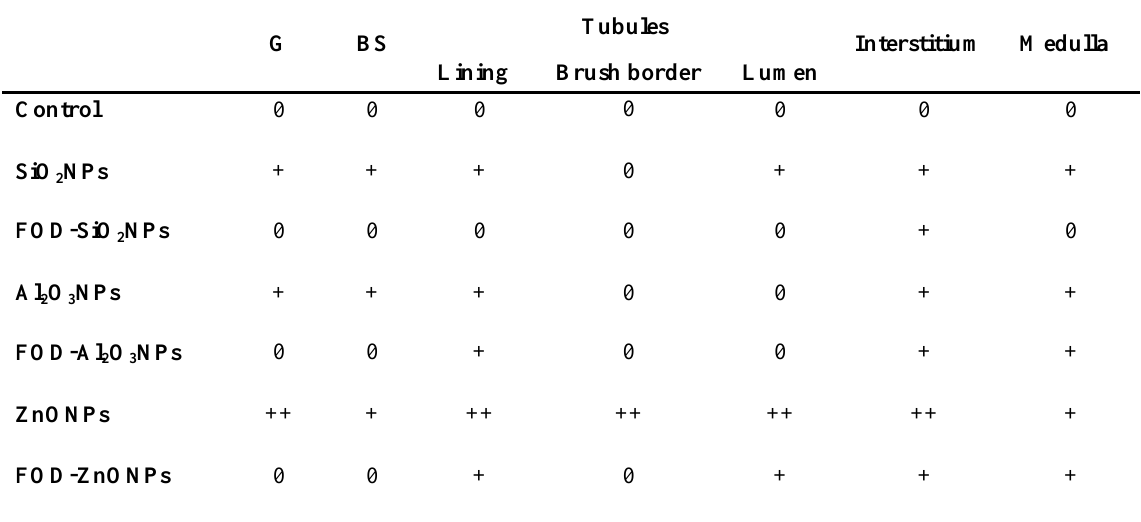
FOD, fig with olive oil and date-palm fruit extracts; SiO 2 NPs, silicon oxide nanoparticles; Al 2 O 3 NPs, aluminum oxide nanoparticles; ZnONPs, zinc oxide